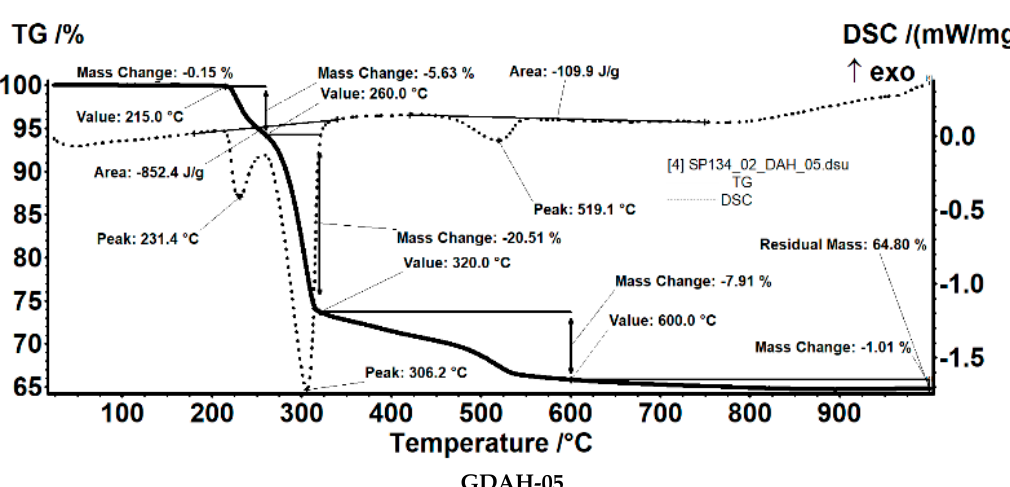
Figure 1. TG and DSC curves of aluminum hydroxide powders heated at 10°C/min.